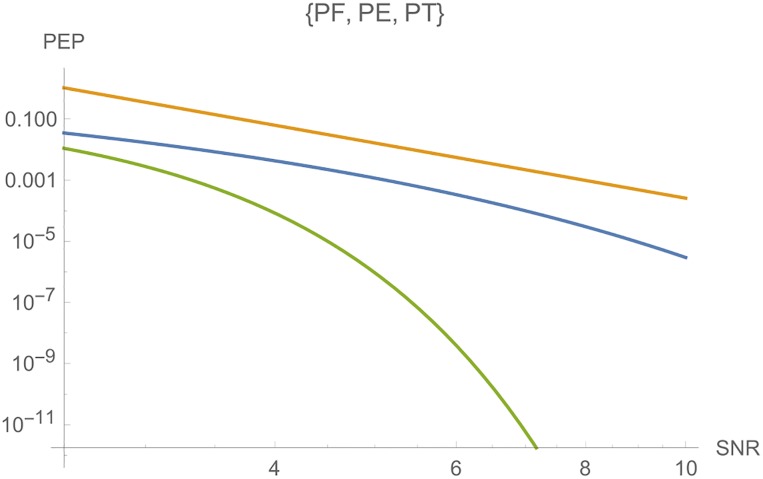
Graphs of PT, PE and PF for nT = nR = l = 2, where the SNR is a function of Es, for c = 5.